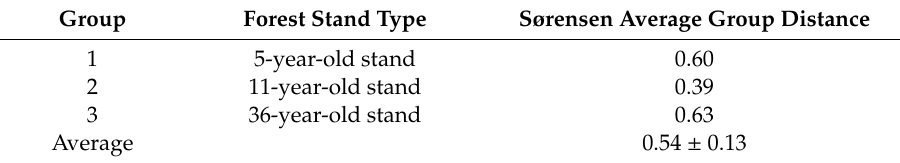
Table 2. Average forest group distances calculated using Sørensen distance matrices to determine whether soil fungal compositions were statistically di ff erent across Pinus patula stands of three di ff erent ages in Wondo Genet, Ethiopia. The average value of all three stand ages ± the standard deviation is also